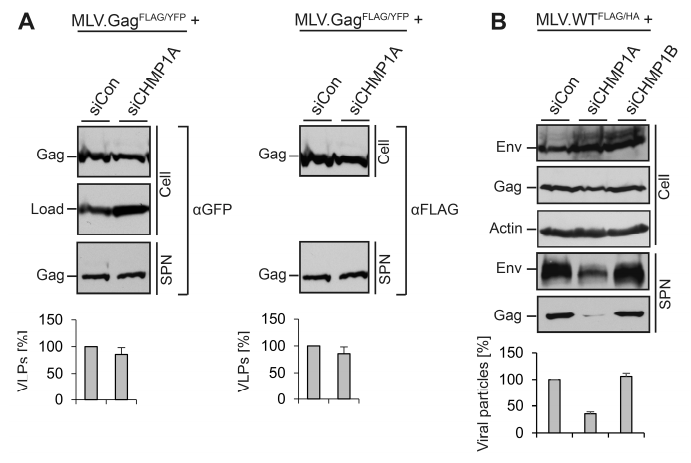
Figure 6. Validation of the role of CHMP1A in viral, but not virus-like MLV particle release. ( A ) CHMP1A is dispensable for the release of FLAG-tagged MLV.Gag FLAG/YFP . HuH-7 cells were treated with control siRNA or siRNA pools targeting CHMP1A. Cells were transfected with an YFP-tagged MLV.Gag construct carrying a FLAG tag within the p12 domain. MLV.Gag FLAG/YFP expression (Cell) and release (SPN) were assayed by FLAG-specific WB prior to GFP-specific immunoblotting of the same blot. Non-specific bands stained by the antisera served as controls for gel loading (Load). The degree of VLP release was quantified by densitometric analysis and demonstrated in percent amount relative to control cells ( n = 2 ); ( B ) CHMP1A is essential for MLV virion release in HEK 293T cells. Following treatment of HEK 293T cells with control siRNA or siRNA pools against CHMP1A or CHMP1B, they were transfected with MLV.WT FLAG/HA . Intra- and extracellular Env and Gag levels were determined by anti-HA and anti-FLAG WB on separate blots. The anti-ß-Actin blot served as a loading control. For quantification of extracellular virions, Env- and Gag-specific signals were measured by densitometry, summed, and demonstrated in percent amount relative to control cells ( n = 2 ).